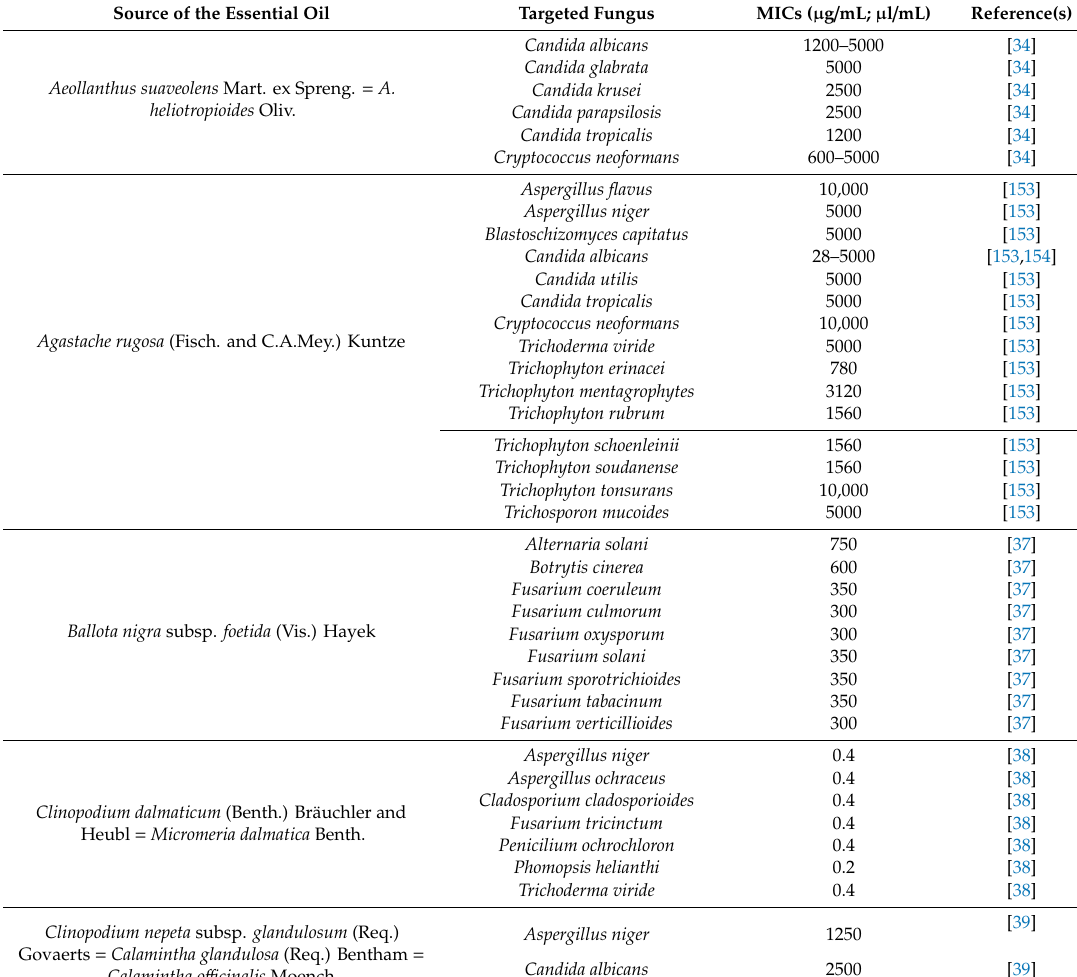
Table 3. Minimal inhibitory concentrations (MICs) of essential oils against